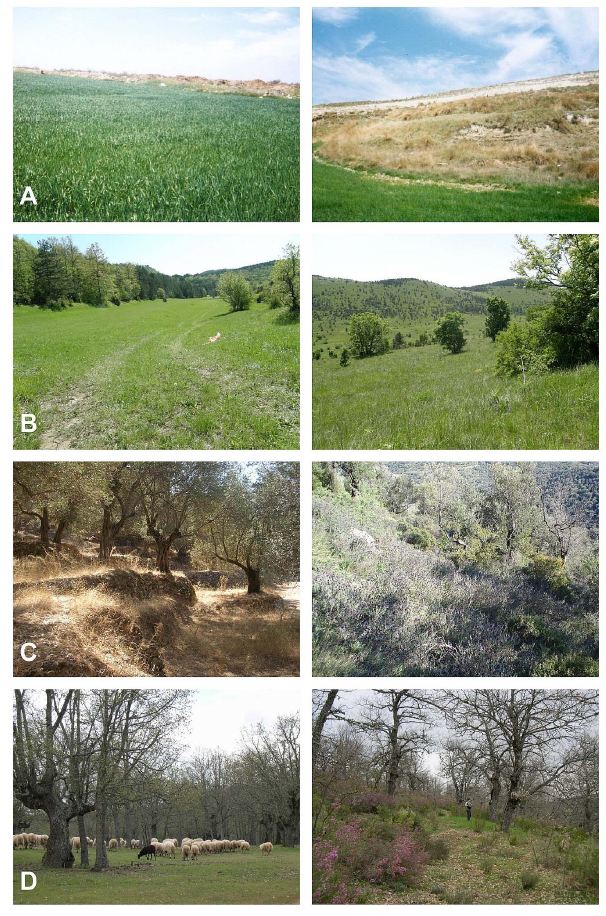
Figure 1. Examples of active and abandoned farmlands. (a) arable land in Burgos province, Spain; (b) grassland in a North Adriatic pastoral landscape, Croatia; (c) permanent crops: Olive groves on Lesvos, Greece; (d) agroforestry: Quercus pyrenaica dehesa in Leo´n province, Spain (sources: (a) J. Arroyo; (b) I. Kosic´; (c) T. Plieninger, T. Kizos; (d) A. Taboada).